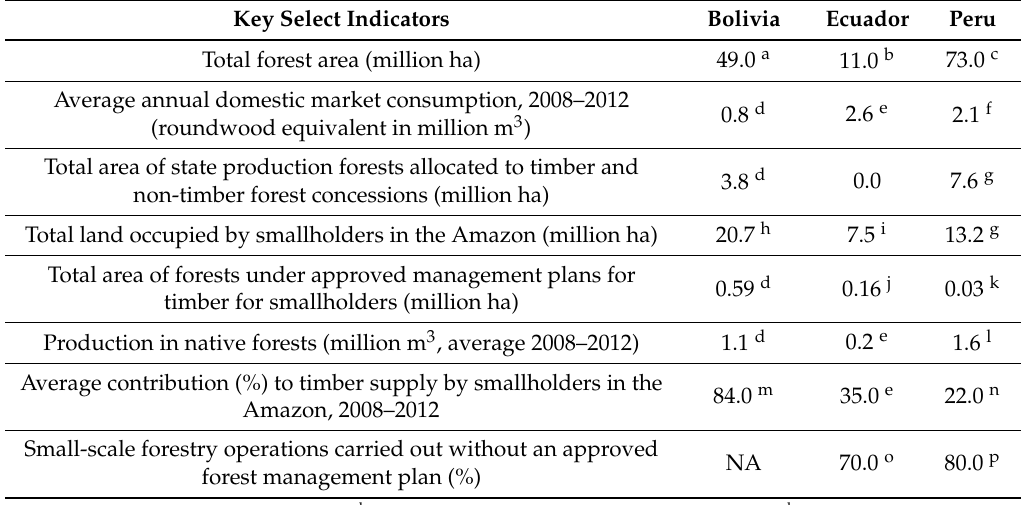
Table 1. Selected Information on the Forestry Sector in Bolivia, Ecuador and Peru. Key Select